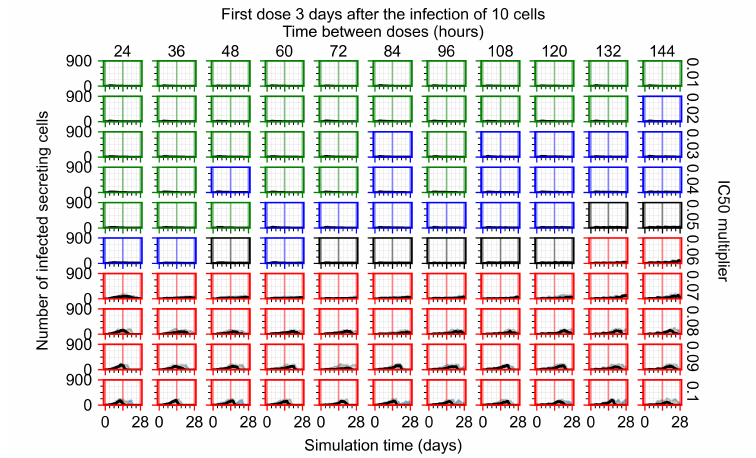
Figure A32. Infected (secreting extracellular virus) population.